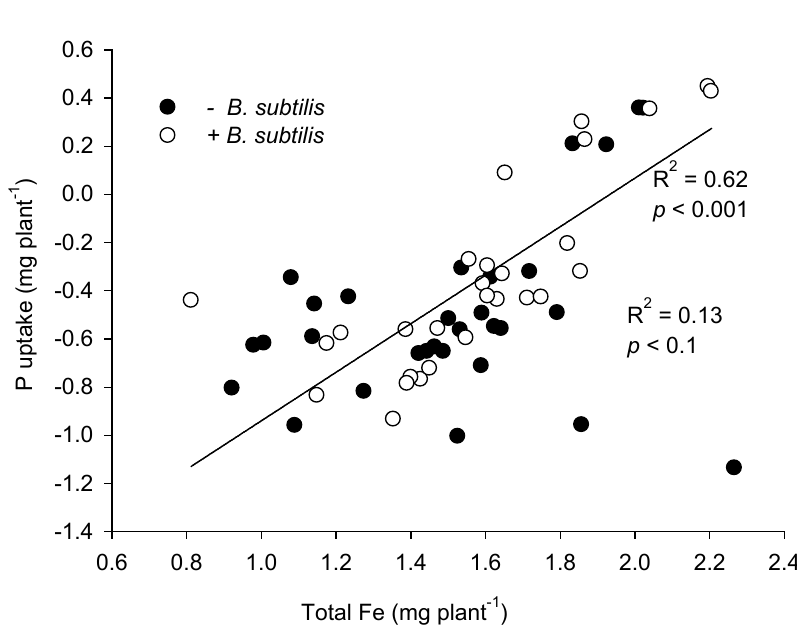
Fig. 1. Log-normalized relationship between P uptake by plants and total Fe in plants; solid line for plants inoculated with Bacillus subtilis QST713 and dotted line for non- inoculated